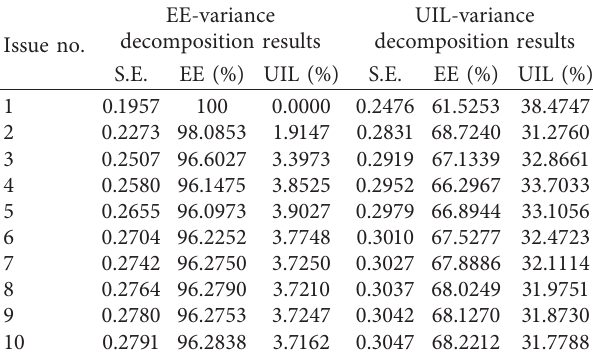
Table 10: Variance decomposition results. Issue